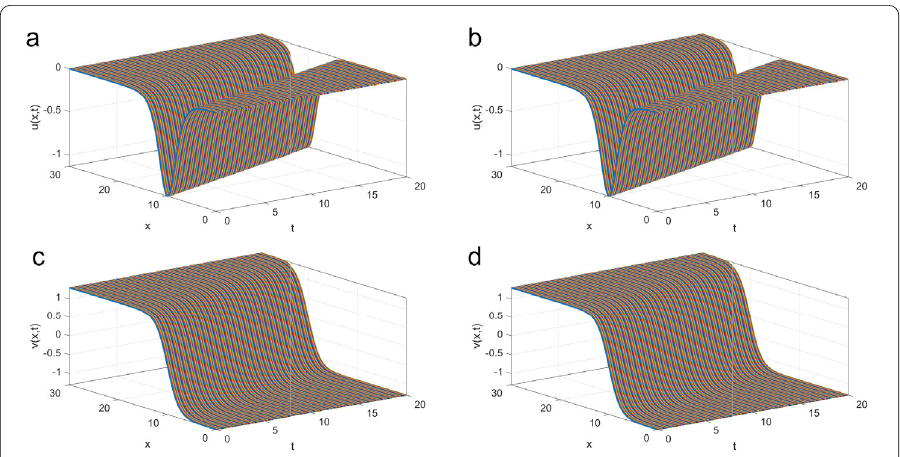
Figure 2 A 3D surface that shows one traveling wave for the exact solution u ( x , t ) is depicted in Figure ( a ), whereas the surface in ( b ) illustrates the numerical solutions for u ( x , t ). Figures ( c ) and ( d ) show 3D surfaces for the evolution time and the numerical solution of v ( x , t ), respectively